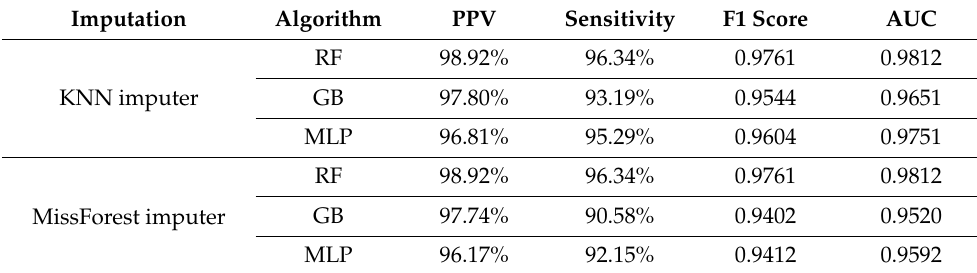
Table 7. Performance comparison of KNN and missForest based on RF, GB, and MLP.